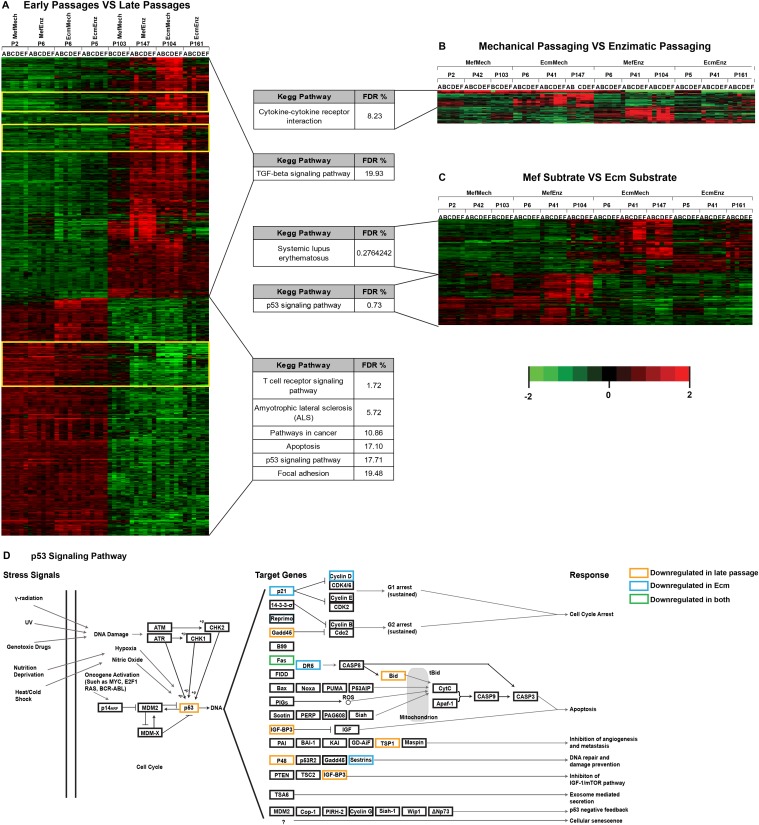
Differences in gene expression with time in culture, passaging method, and media type.Heatmaps showing differentially expressed genes for early vs. late passage (A), mechanical vs. enzymatic passage (B), and Mef vs. Ecm substrate (C). In heatmap (A), the yellow boxes indicate genes for which the expression levels in the late passage MefMech (P103) samples was similar to those in the early passage samples. Probes were selected by multivariate regression. Enrichments in KEGG pathways identified by functional enrichment analysis are shown. Samples were arranged according to passage and culture method, and hierarchical clustering was performed on the genes only. D. Diagram of the TP53 signaling pathway, showing genes downregulated in the late vs. early passage samples, and the Ecm vs. Mef substrate comparisons.